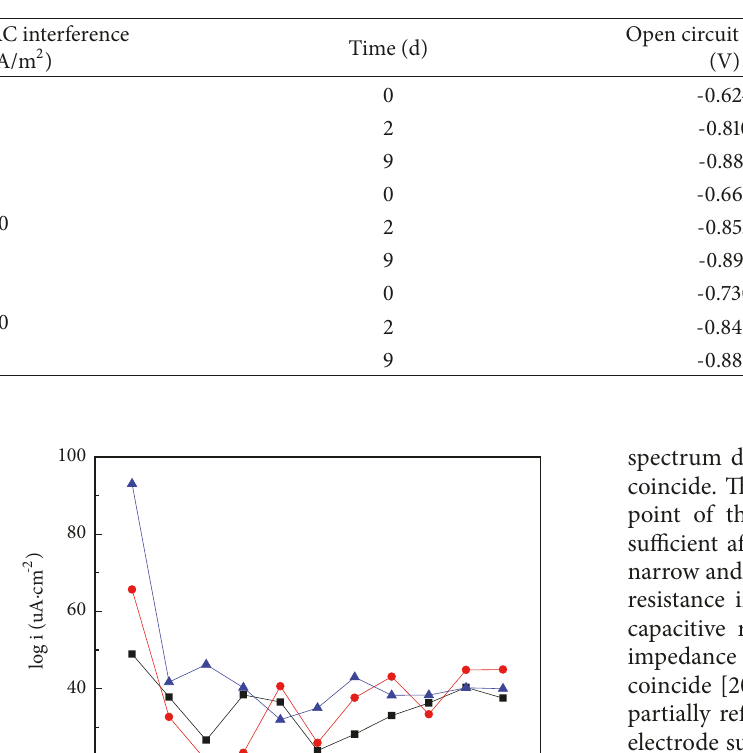
Table 3: Electrochemical parameters fitted from polarization curves under different AC current densities.